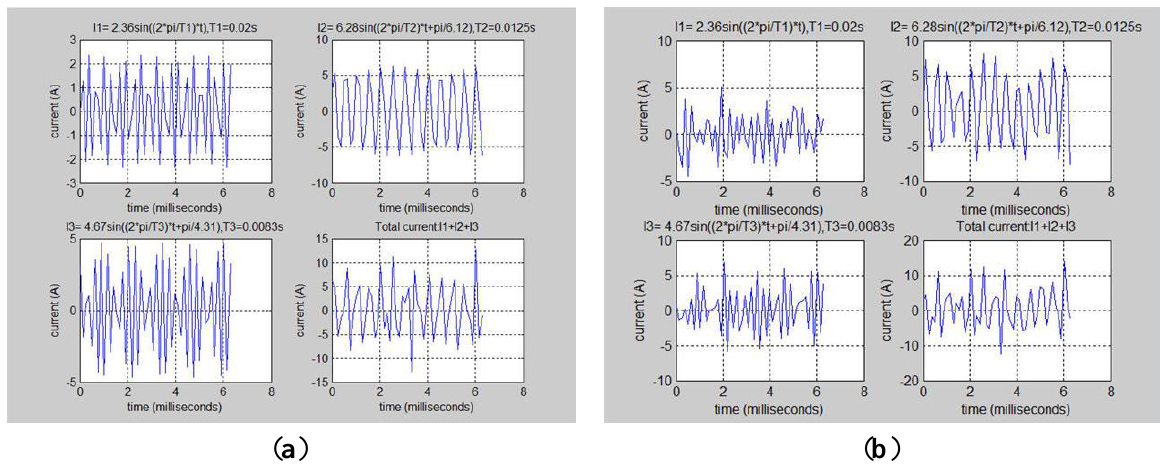
Figure 46. The ideal values are compared to the actual measured load current values. ( a ) Ideal value of load current; ( b ) Actual value of load